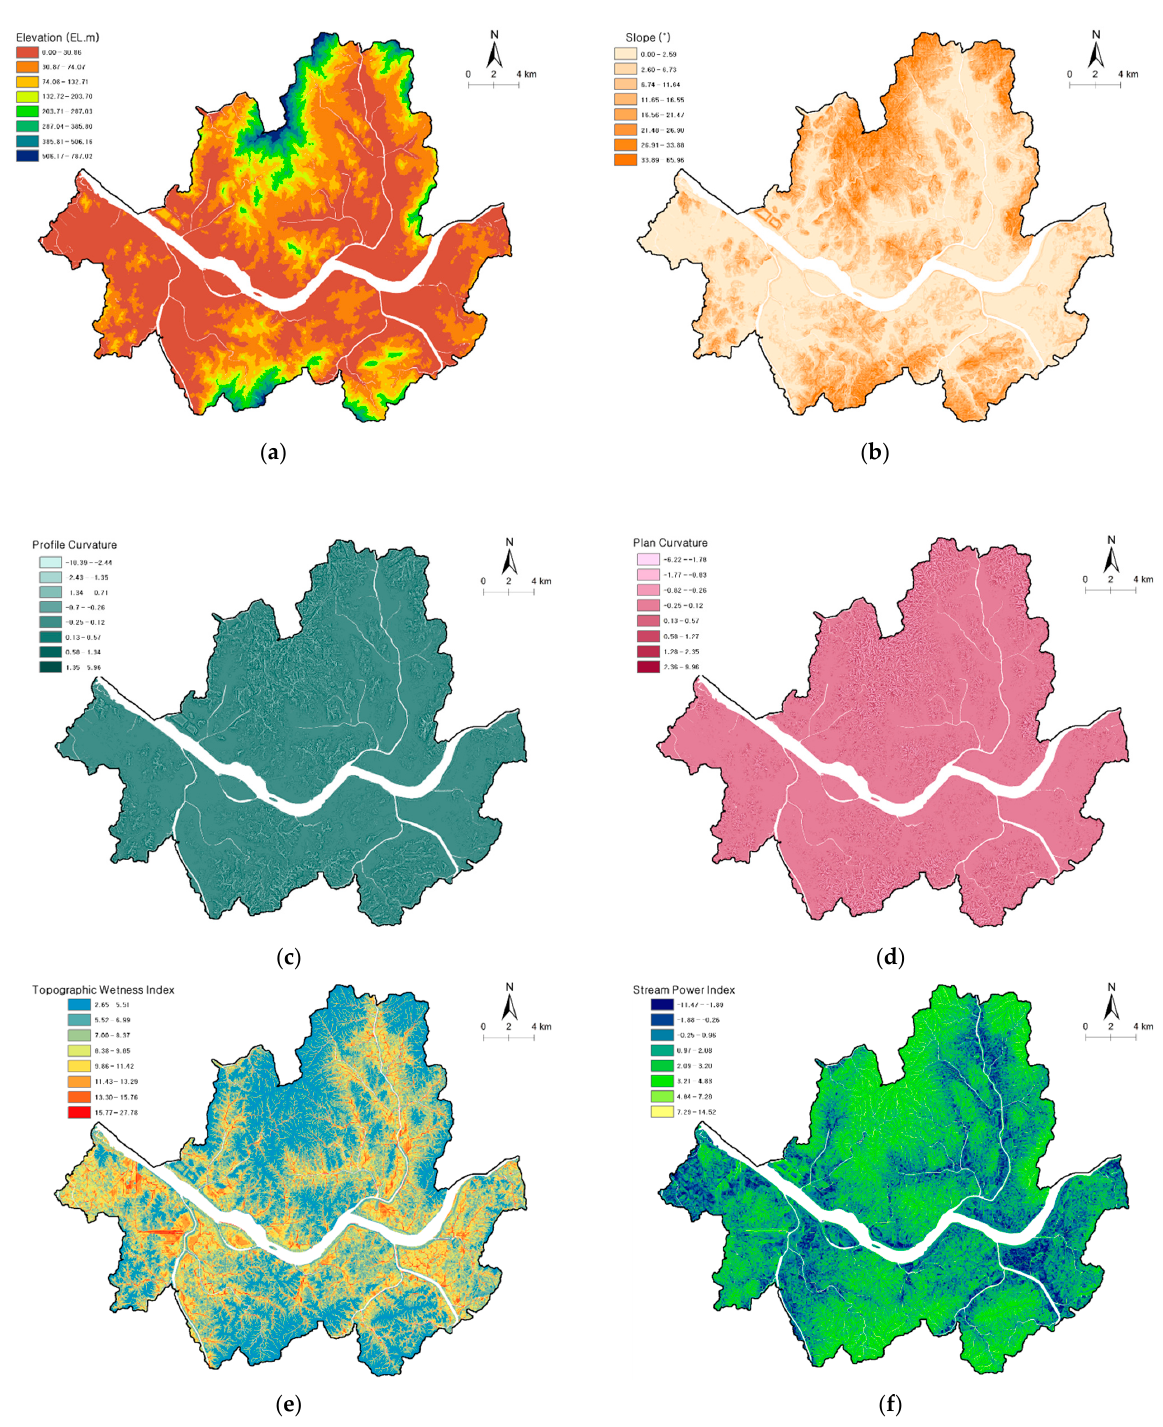
Figure 3. Topographic factors: ( a ) Elevation; ( b ) Slope; ( c ) Profile curvature; ( d ) Plan curvature; ( e ) Topographic wetness index (TWI); ( f ) Stream power index (SPI).